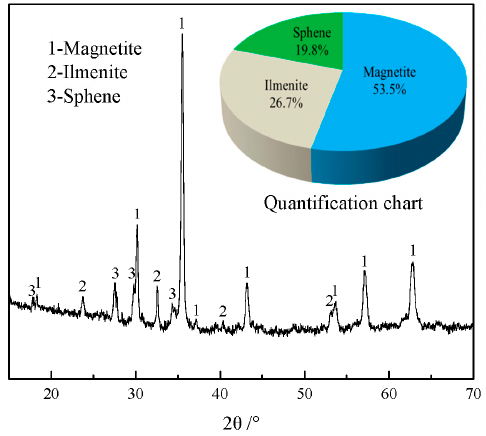
Figure 6. XRD patterns of the vanadium-titanium magnetite concentrate.